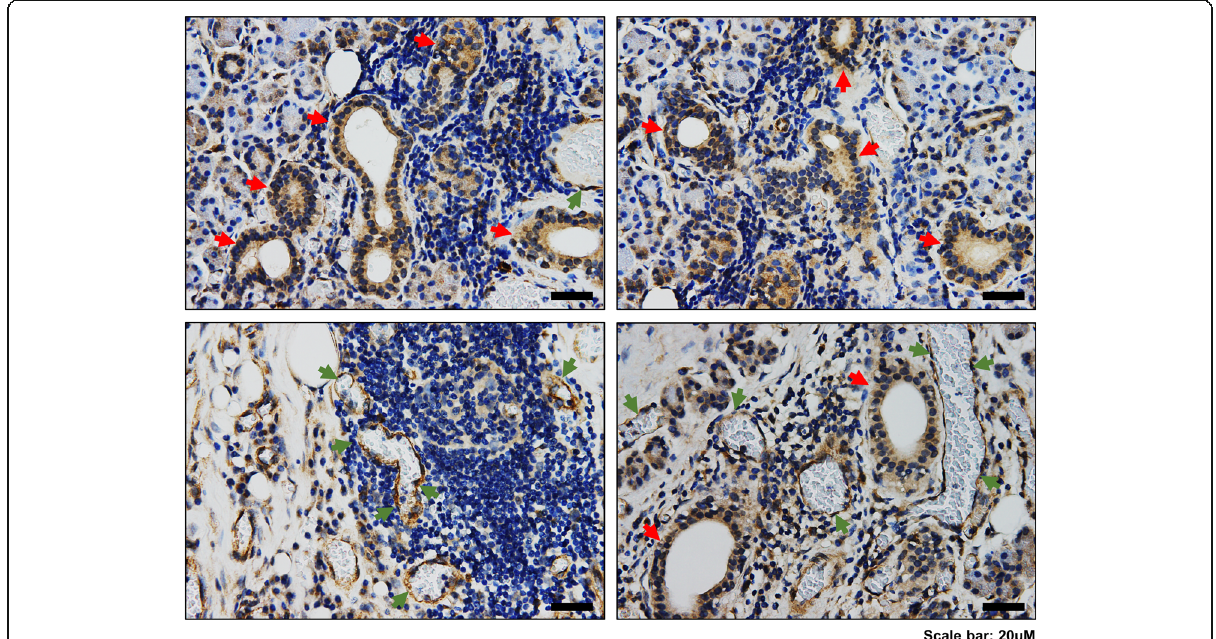
Fig. 3 High expression of IL-34 in ductal epithelial cells and endothelial cells of blood vessels correlates with high infiltration of immune cells. Representative data of IL-34 staining by IHC showing the localized expression of IL-34 in ductal epithelial cells and endothelial cells of blood vessels. Hematoxylin staining demonstrates lymphocyte accumulation around IL-34-expressing epithelial (red arrows) or endothelial (green arrows) cells. Scale bars, 20 μ